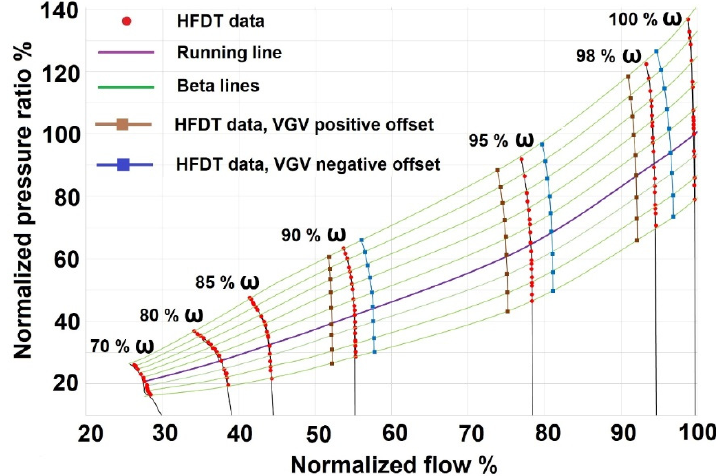
Figure 1. Pressure ratio estimated by high-fidelity design tool (HFDT) in overall compressor performance map. performance